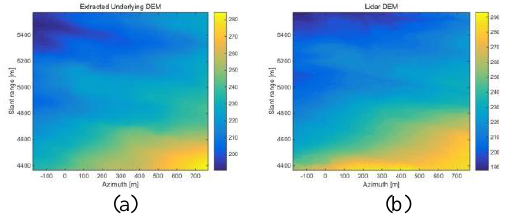
Figure 3. Extracted underlying DEM(a) and Lidar DEM(b)